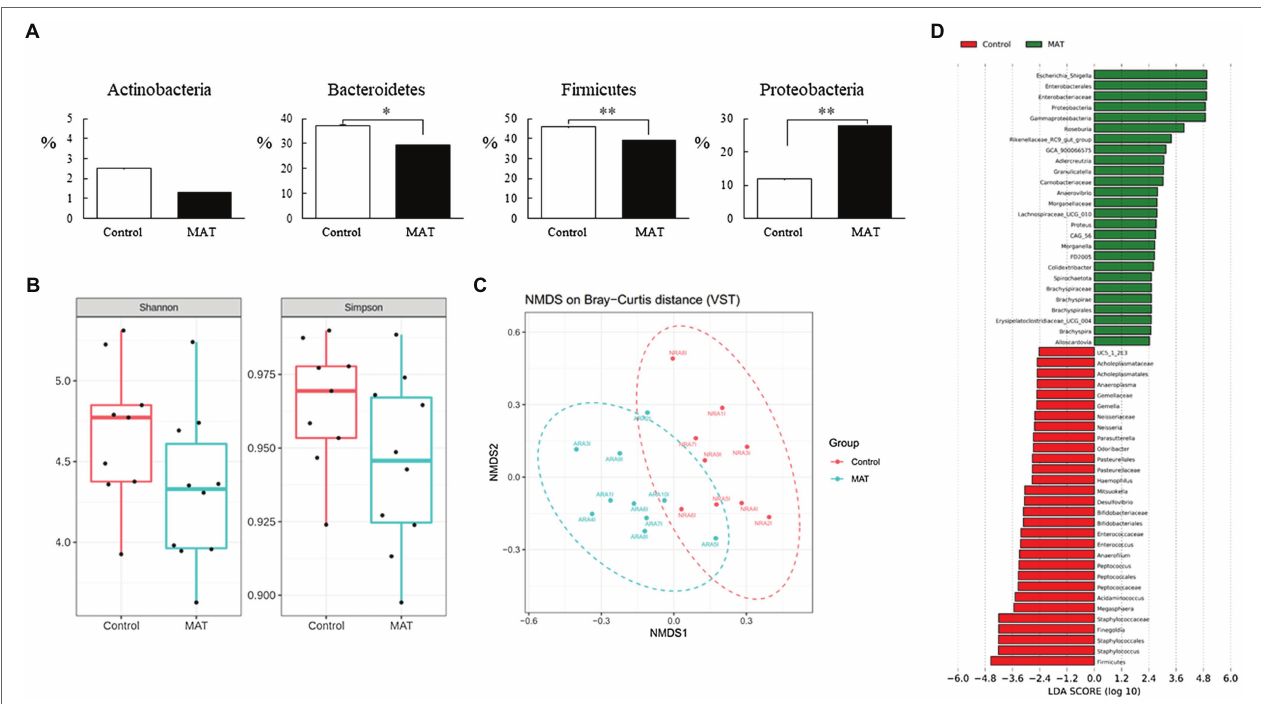
FIGURE 2 | Effects of MAT on (A) bacterial composition at the phylum level, (B) α diversity, (C) NMDS, and (D) histogram of the linear discriminant analysis scores of bacterial at the family level of the intestinal microbiota in 7-day-old mice. MAT altered the bacterial composition and diversity of the intestinal microbiota in 7-day- old offspring. MAT significantly reduced the relative abundances of Bacteroidetes and Firmicutes and significantly increased the relative abundance of Proteobacteria in the intestine compared with the abundances in the control group. No significant differences in Shannon diversity or Simpson diversity were observed between the control and MAT groups. NMDS revealed that the intestinal microbiome in the control group was significantly different from that in the MAT group. Bacterial taxa significantly differed across the control and MAT groups identified by LEfSe using the default parameters. * p < 0.05; ** p < 0.01. NMDS, nonmetric multidimensional scaling; and MAT, maternal antibiotic